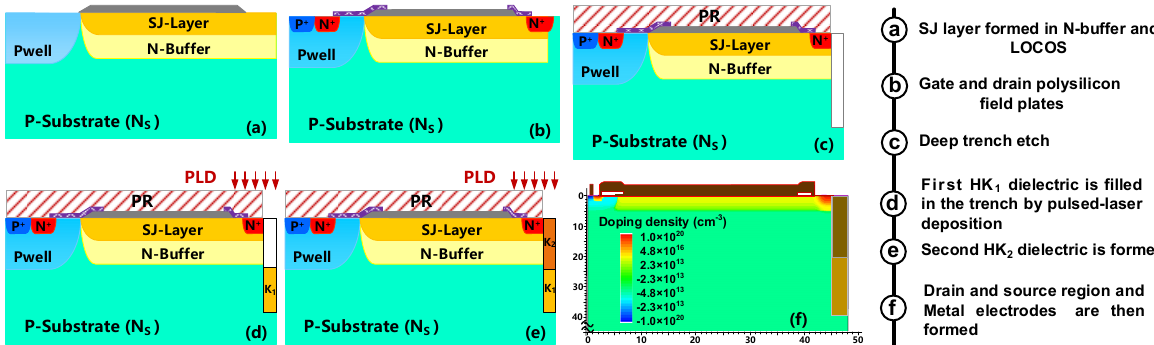
Figure 8. Key process steps for fabricating the proposed VHK SJ-LDMOS. Table 2. Key parameters in the process.